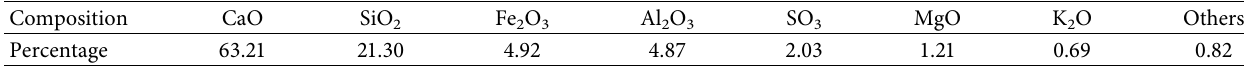
Table 1: Chemical composition of the OPC.